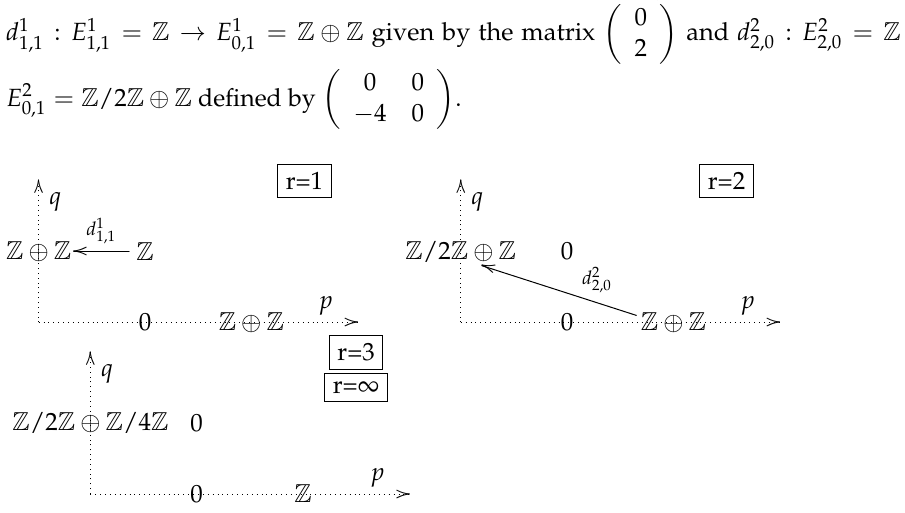
Figure 3. Spectral sequence of the